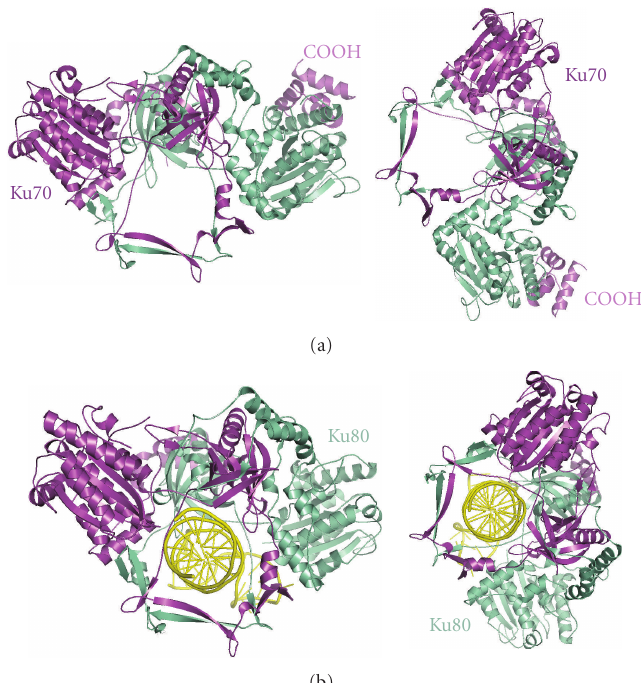
Figure 3: Heterodimerisation of Ku70/80 defines a ring shape that binds DNA. Crystal structures of Ku70/80 heterodimer in the absence of DNA (a) and in DNA-bound form (b). Adapted from [10].